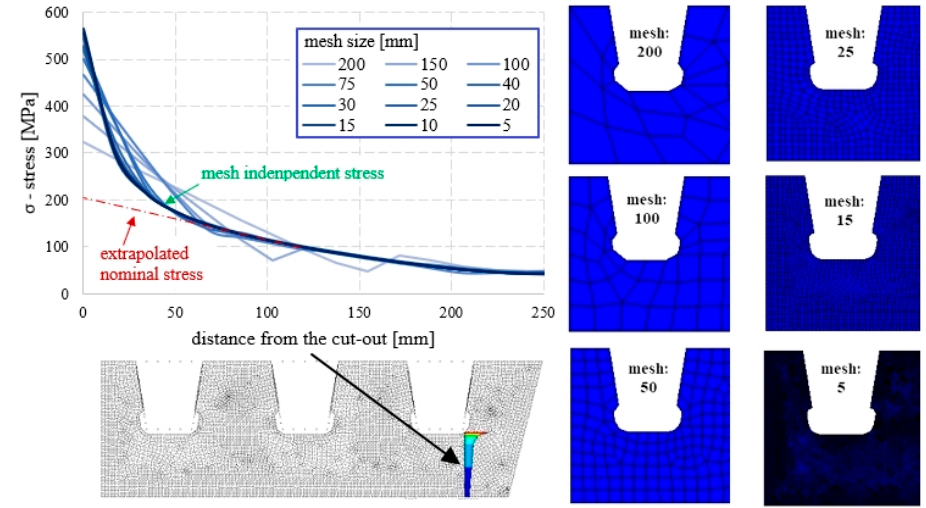
Figure 9. von Mises stresses obtained from the linear analyses along the evaluation path using different mesh sizes (units in (MPa)).